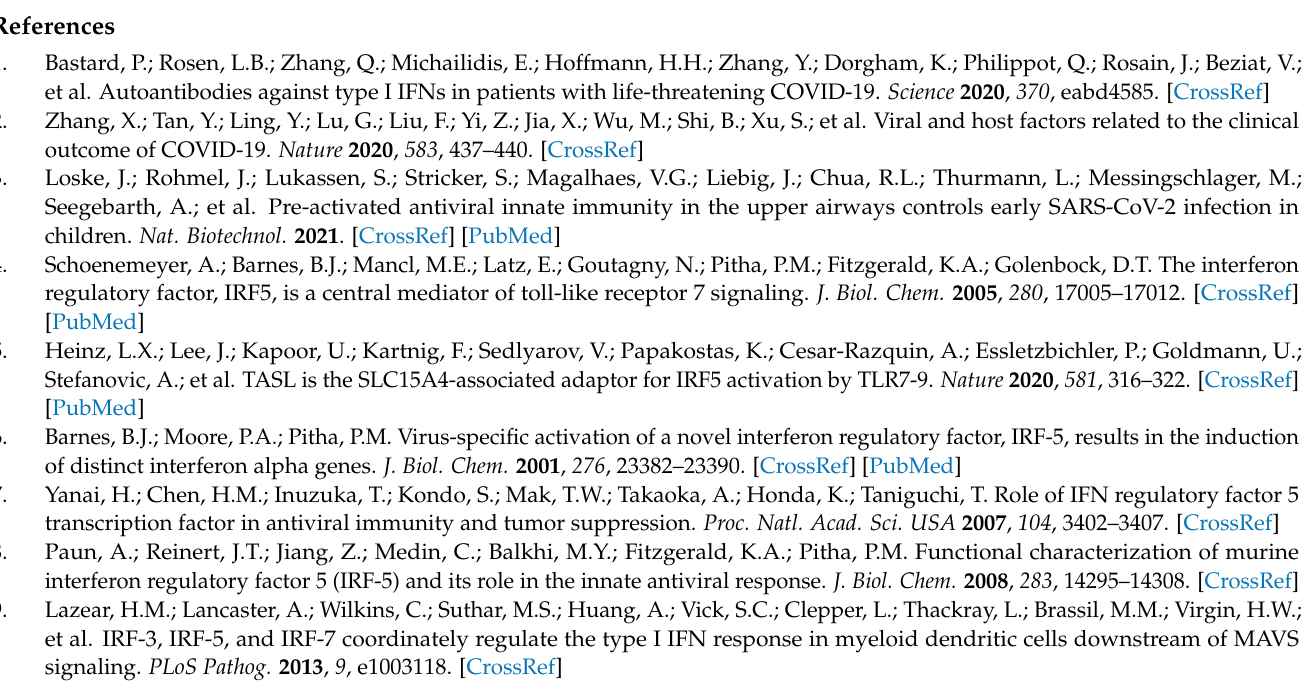
mentary Figure S2: Knockout validation and mutual dependency of IRFs (RVFV), Supplementary Figure S3: Impact of IRFs on ISG induction, Supplementary Figure S4: Impact of IRFs on RIG-I- dependent and RIG-I-independent signaling, Supplementary Figure S5: Proinflammatory cytokine and chemokine profiles of IRF KO cell lines after RIG-I-specific stimulus, Supplementary Figure S6: IFN- β production upon IRF5 KO, Supplementary Figure S7: Validation of A549 IRF1, IRF5 and IRF7 overexpression cell lines. Statistics.xlsx: results of statistical testing for Figures 4–7 (see